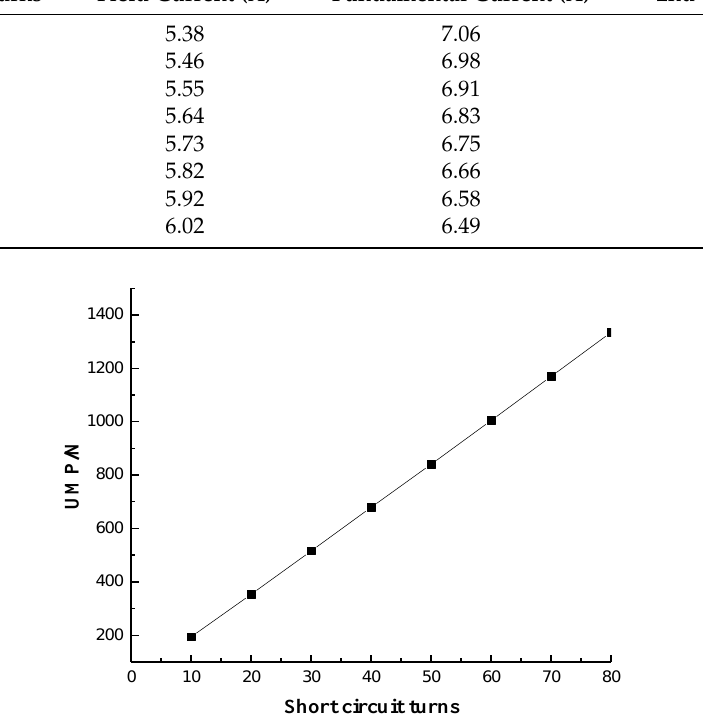
Figure 15. Relationship between short circuit turns and UMP. UMP shows the approximate linear increase variation law with the increasing short circuit